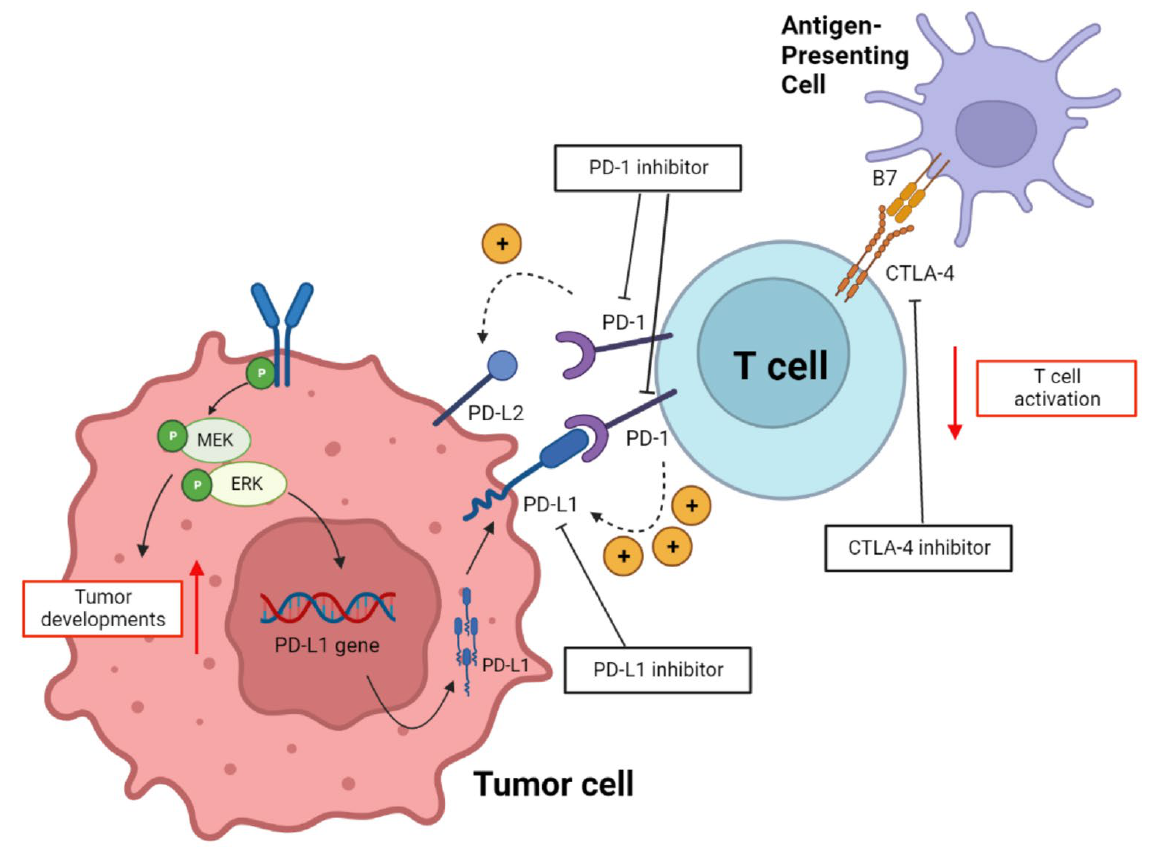
Figure 1. Interaction between PD-1/PD-L1 and CTLA-4/B7 in the immune system and mechanism expression of PD-1/PD-L1 inhibitor and CTLA-4 inhibitor.